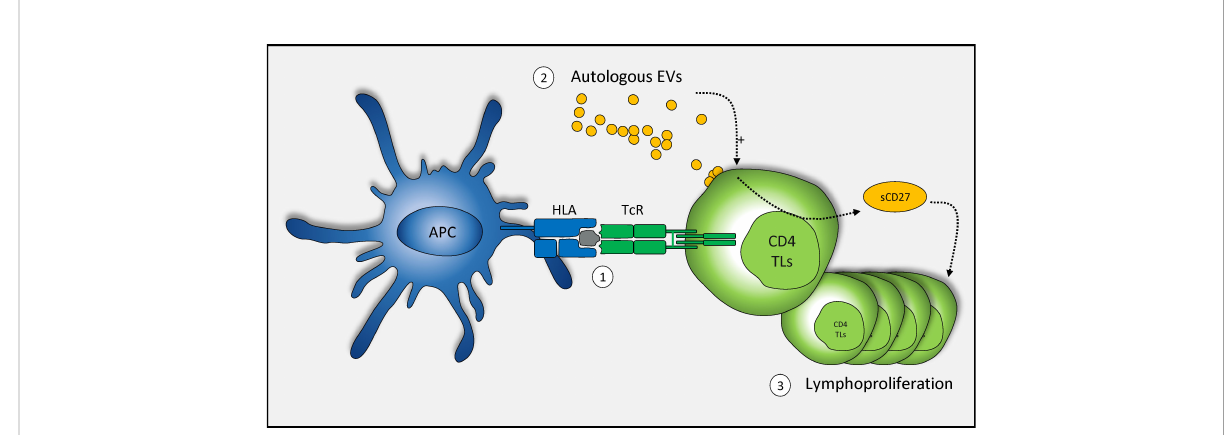
FIGURE 4 Schematic representation of the mechanism of action of autologous blood EVs in CD4 + TL activation. TcR engagement and autologous EVs enhance the T cell-mediated immune response. (1) Once the TcR is committed in response to stimulation, (2) autologous EVs play a role in the secretion of sCD27 (3) potentially leading to a large increase in T-cell